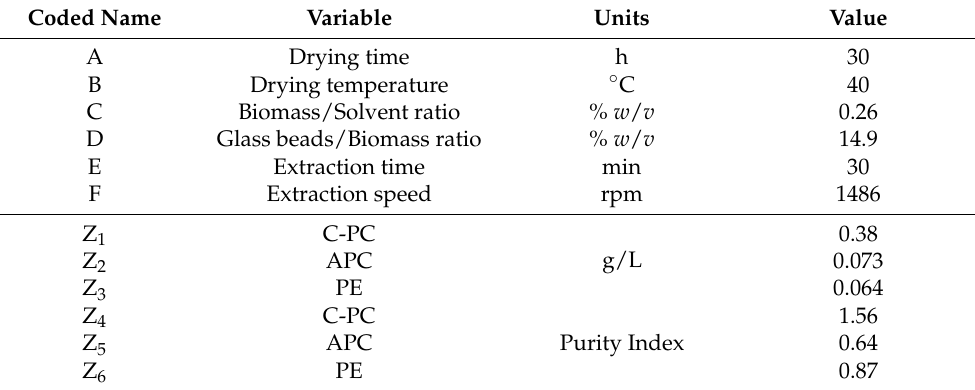
Table 4. Variables for optimal biomass concentration on both strains were studied.